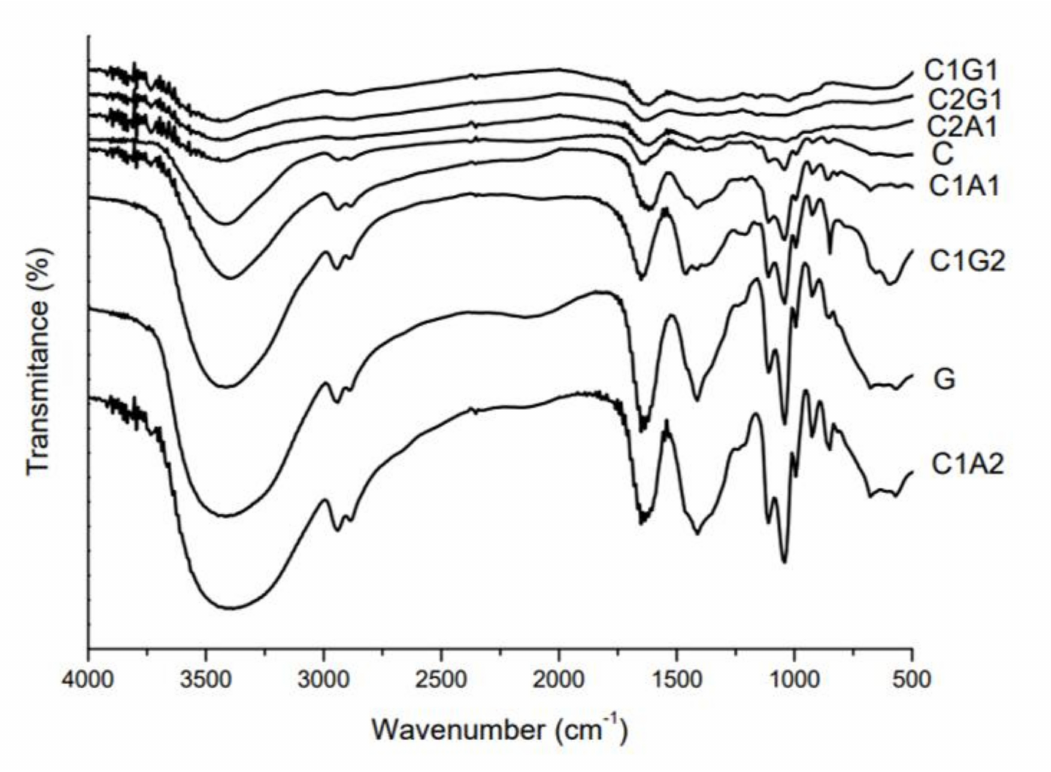
Figure 7. FTIR spectrum of SAH based on polymers and polyelectrolyte